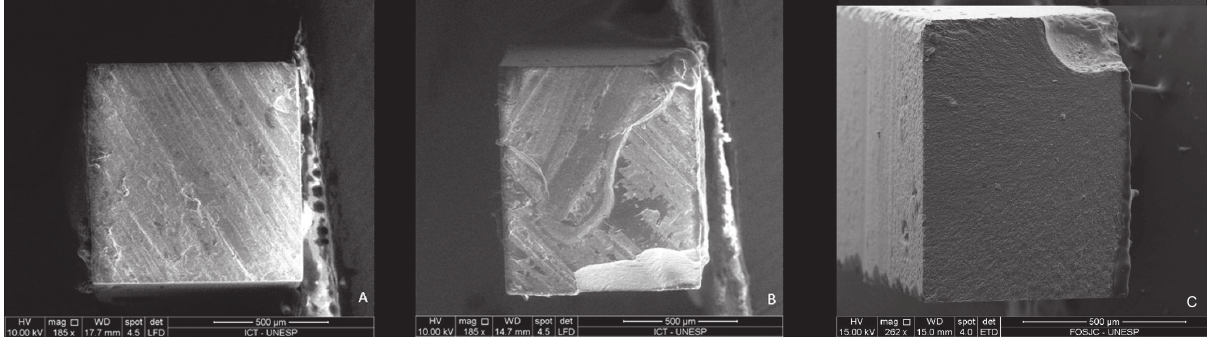
*The same superscript letters indicate no significant differences in columns (Tukey’s test, α =0.05) **Only the SP group showed statistical difference between dry and thermocycling groups